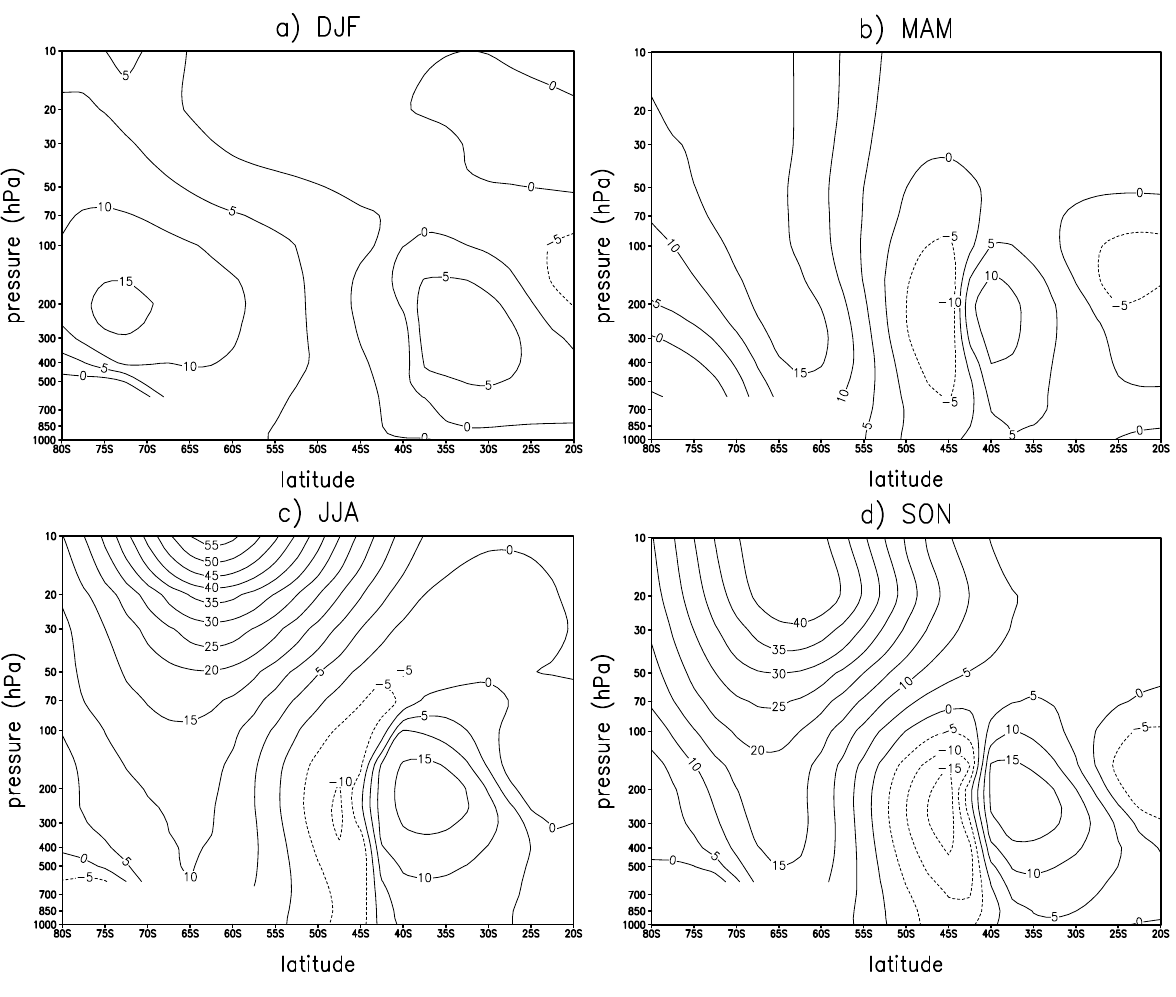
Fig. 4. Difference of amplitude of QS wave 1 (m) between El Ni˜no composite and the mean for: (a) DJF, (b) MAM, (c) JJA, and (d) SON. Contour interval is